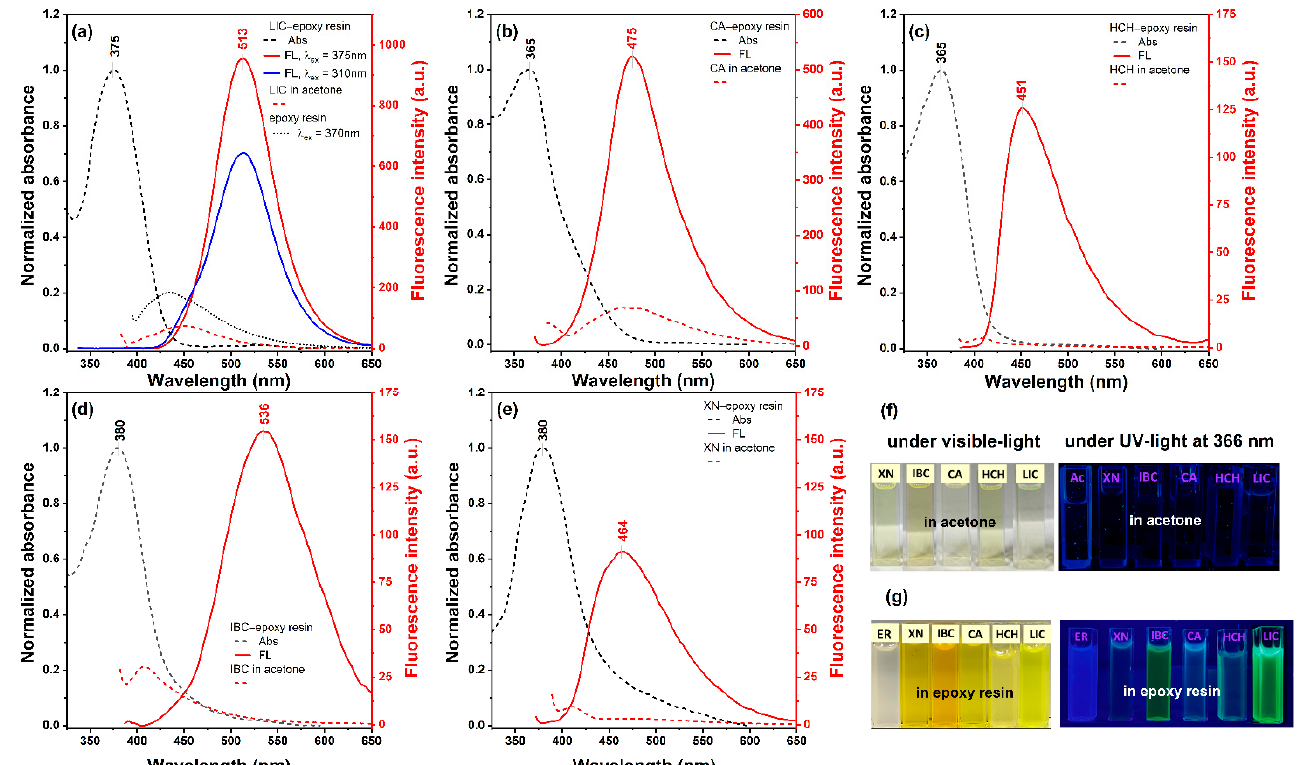
Figure 5. Normalised absorption (dashed black lines) and fluorescence spectra of ( a ) LIC, ( b ) CA, ( c ) IBC, ( d ) XN and ( e ) HCH in the epoxy resin (solid red lines) and acetone (dashed red lines). Fluorescence spectra were recorded with the excitation wavelength at the absorption maximum of each compound in the solid state. ( f ) Photographs were taken in acetone (Ac) and ( g ) in the epoxy resin (ER) blended with chalcones in the acetone solution (20:1, v / v ) in visible light and the illumination of UV light (366 nm).